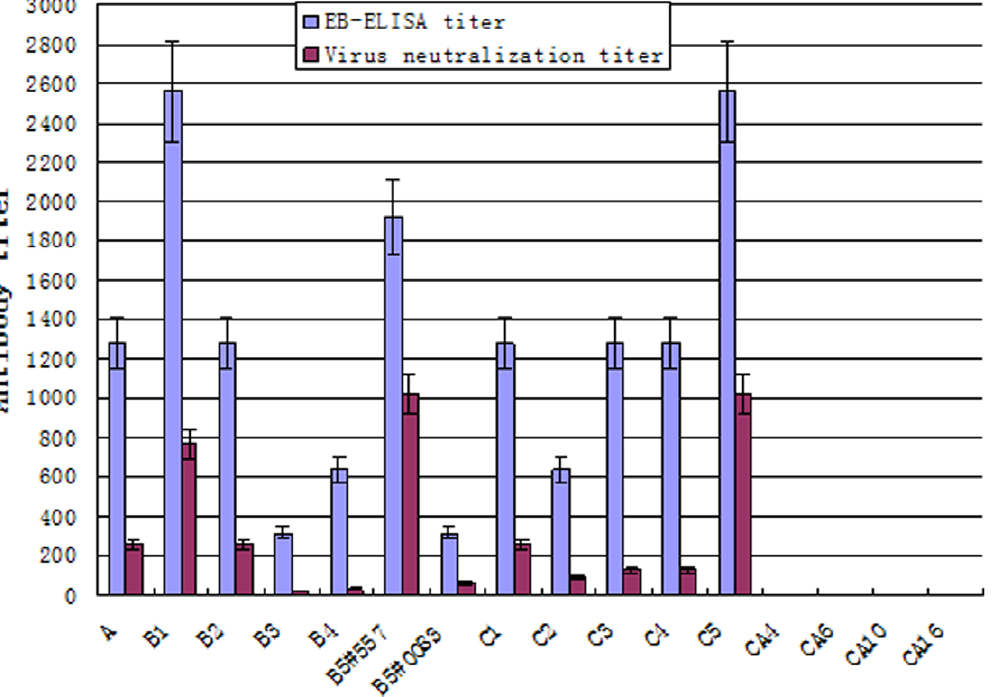
Figure 4. Comparison of EB-ELISA to microneutralization assay. The EV71 antibody detection sensitivity and specificity of the EB-ELISA and microneutralization assays were compared using guinea pig immune sera collected 14 days after the 2nd immunization to determine the endpoint of inhibition. The EB-ELISA titer was determined as described in the Methods section. The neutralization assays were performed using B5 NUH0083 EV71 virus. The results were expressed as the geometric mean titers (n=4/group, whiskers above bars represent the standard error of the mean). doi:10.1371/journal.pone.0055517.g004 PLOS ONE |